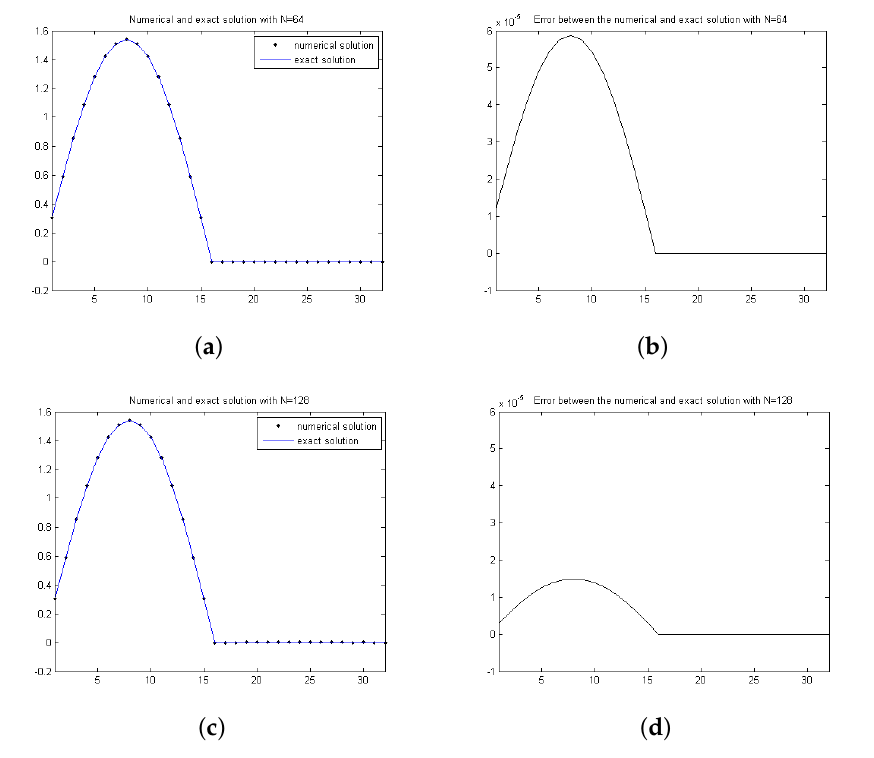
− u ( b , d ) for experiment 2. h